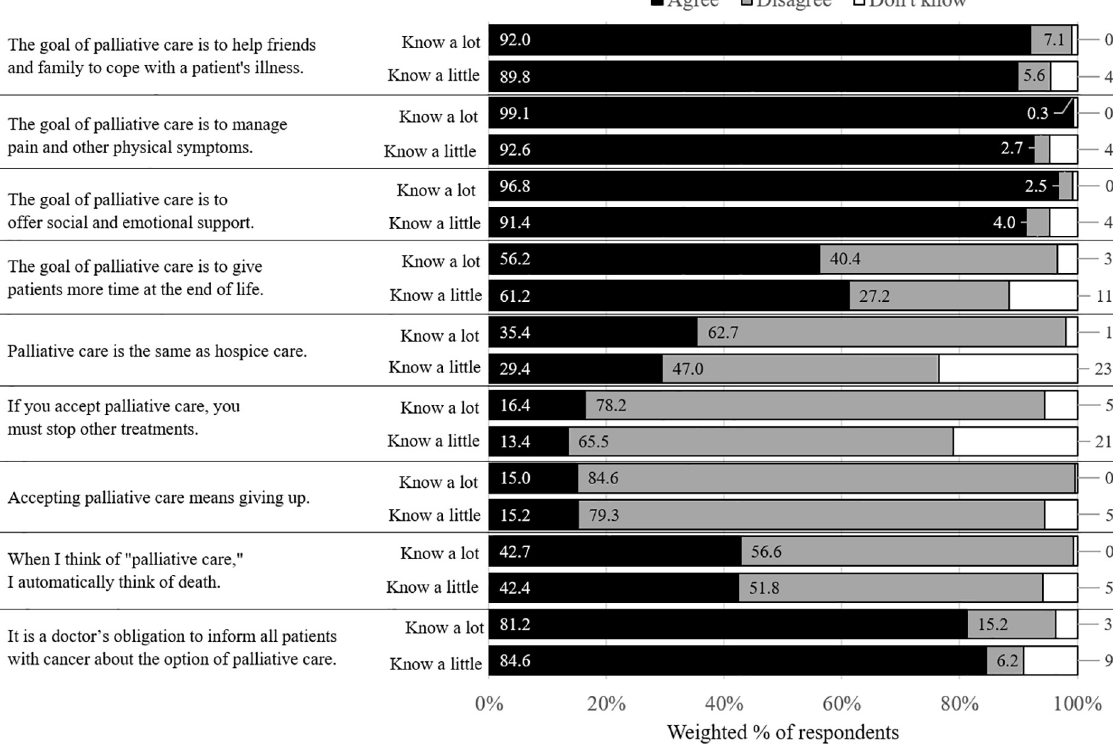
Fig 1. Proportion of respondents agreeing, disagreeing, and responding DK with each palliative care knowledge and belief item as a function of self-assessed awareness about palliative care (know a lot versus know a little).